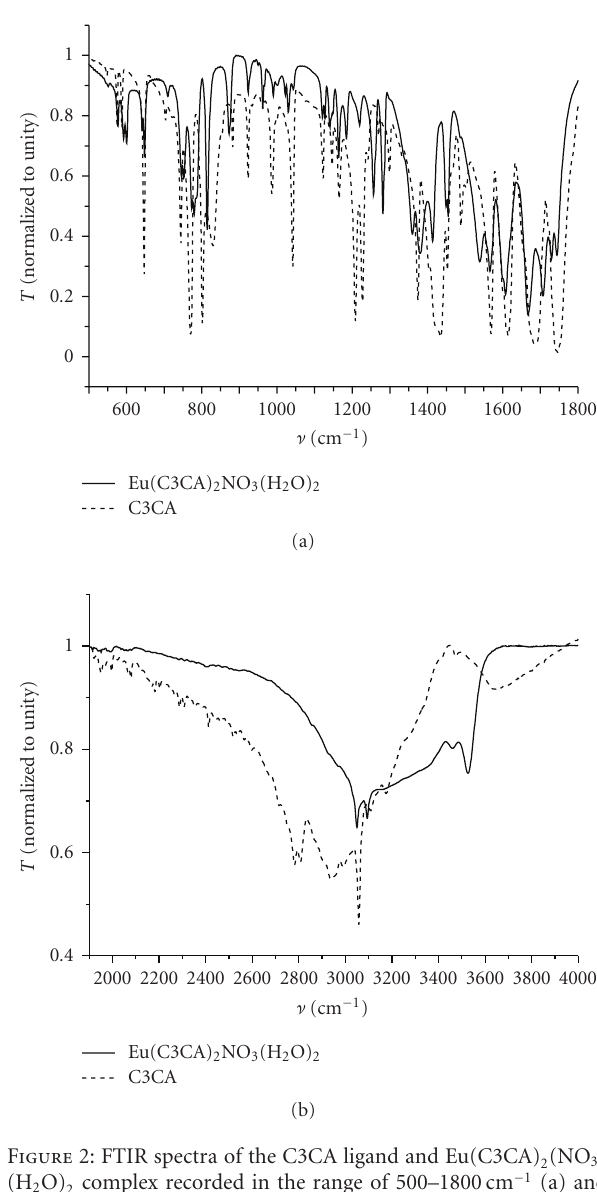
Figure 2: FTIR spectra of the C3CA ligand and Eu(C3CA) complex recorded in the range of 500–1800 cm − 1 (a) and (H 2 O) 2 2000 and 4000cm − 1